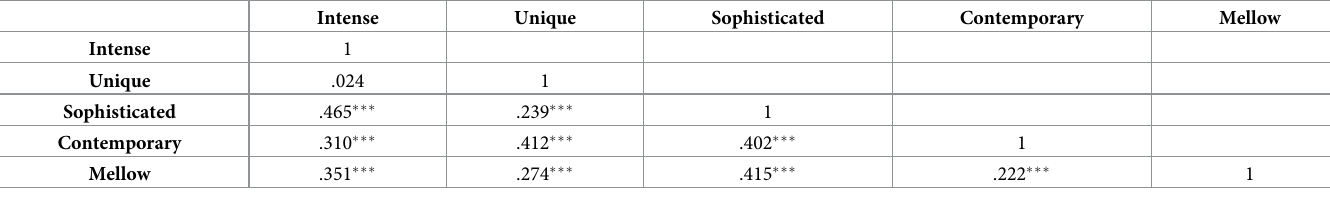
Table 2. Pearson correlations for musical dimensions.